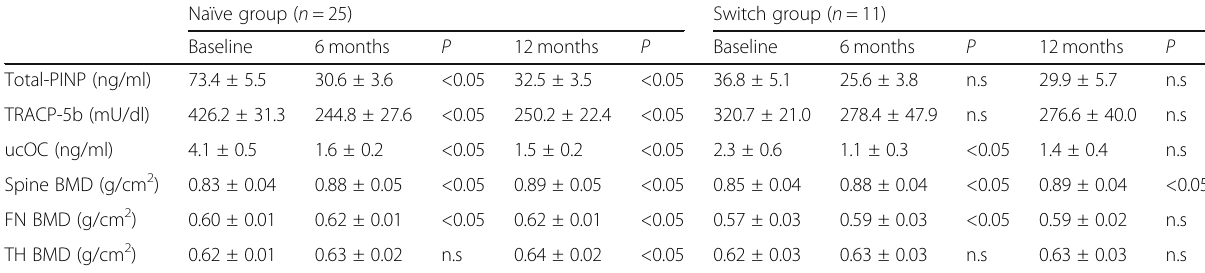
Table 4 Changes of bone turnover markers and BMD in the naïve and switch groups after 6 and 12 months of treatment